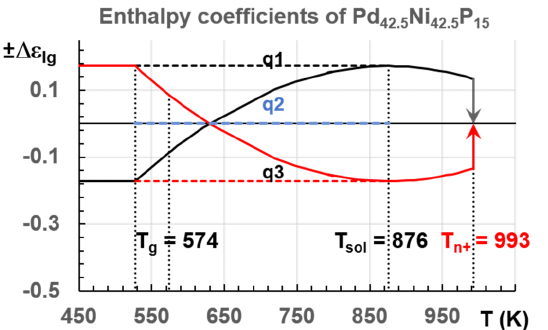
Figure 9. The enthalpy coefficients of Pd 42.5 Ni 42.5 P 15 versus T (K). T n+ = 993 K; Tsolidus = 876 K; T g = 574 K; T 3 = 527.3 K. The enthalpy coefficients (±Δε lg ) given by (15) versus T (K). Three quenching lines q1, q2, and q3 along +Δε lg0 = 0.17237, 0, and −Δε lg0 . 6. First-Order Liquid–Liquid Transitions Observed in Pd 42.5 Ni 42.5 P 15 , La 50 Al 35 Ni 15 , and Fe 2 B